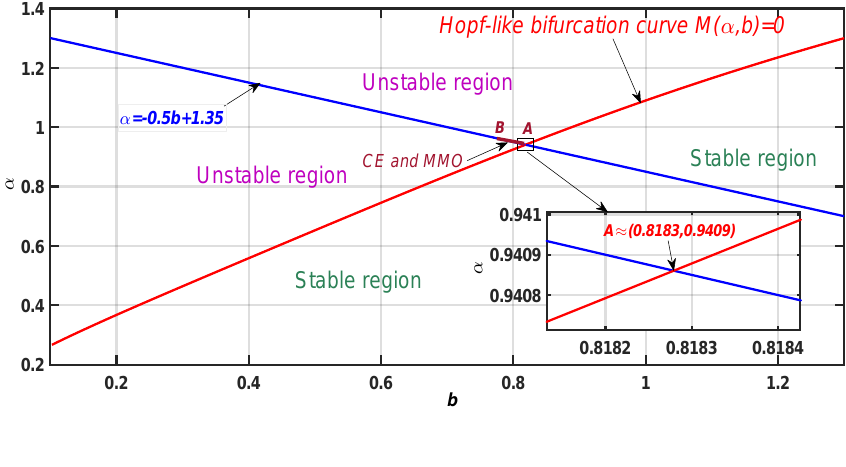
F IGURE 5 HLB curve in the ( b , α ) parameter